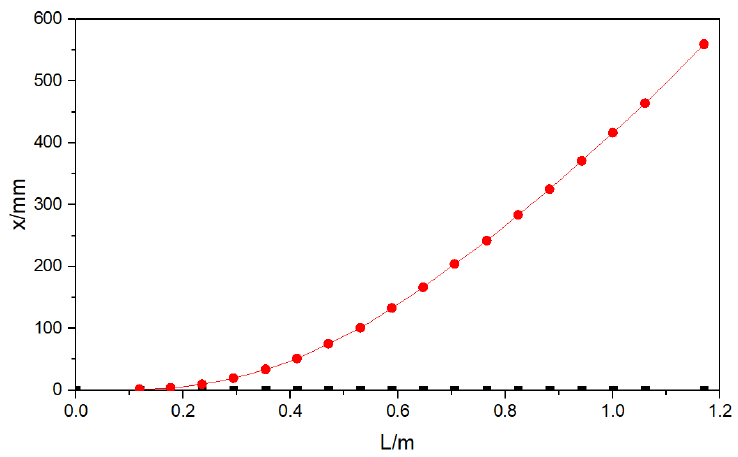
Figure 15. Bullet x (transverse) displacement.